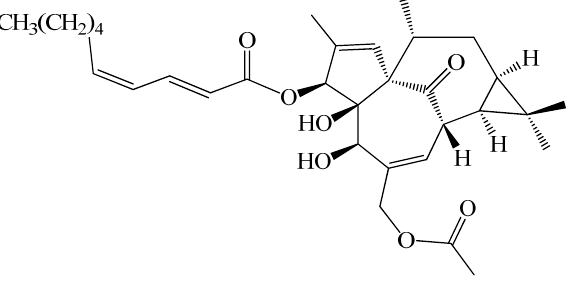
Figure 1. Chemical structure of 3EZ, 20Ac-ingenol.